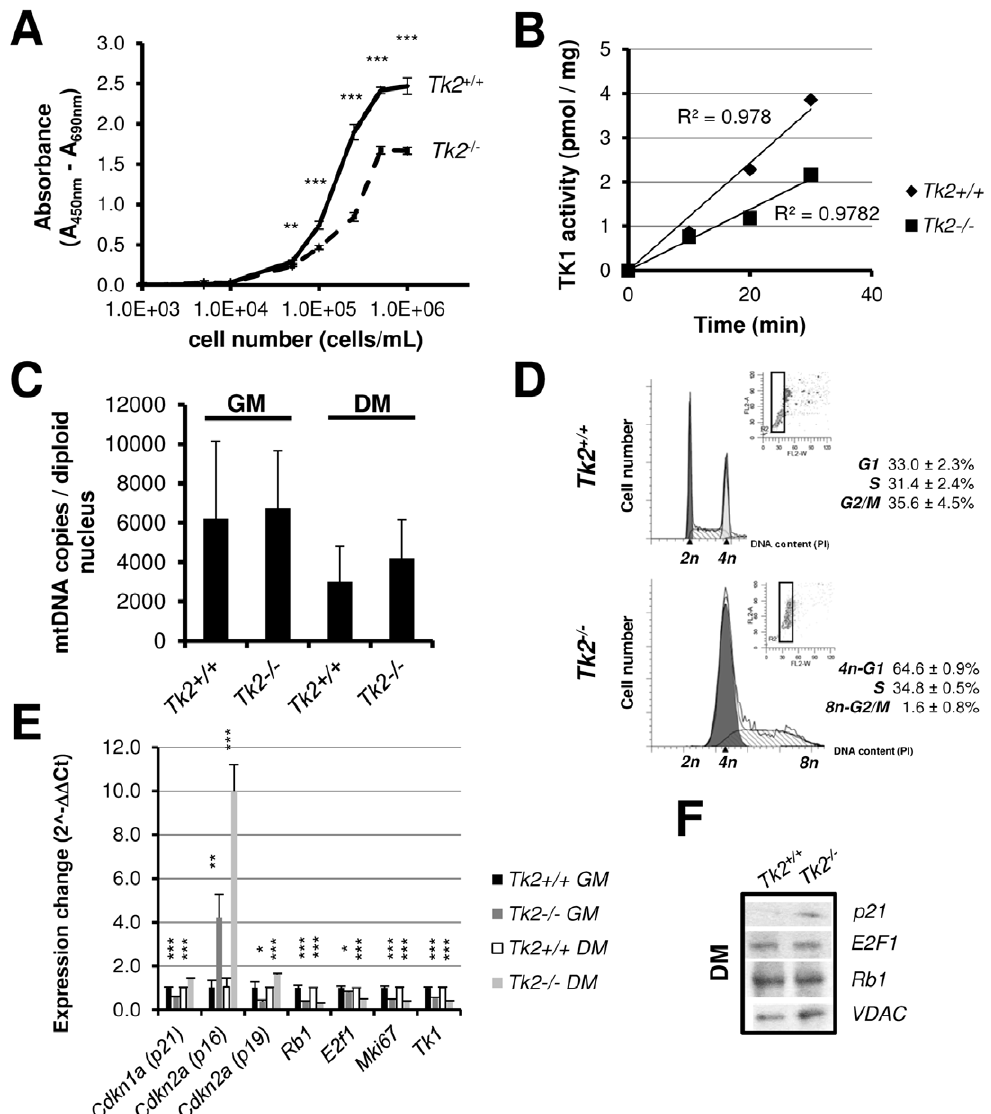
Figure 7. Tk2 + / + and Tk2 2 / 2 primary myoblasts characterization. A ) Growth of Tk2 + / + and Tk2 2 / 2 myoblasts in F-10/DMEM-based primary myoblast growth medium was determined by XTT proliferation assay (see methods). Data points represent mean 6 SD of measurements obtained from 4 independent myoblast cultures ( n =4). The P -values for statistical comparisons (two-tailed unpaired Student’s t-test) between Tk2 + / + and Tk2 2 / 2 data points are shown - ** P , 0.01; *** P , 0.001. B ) Thymidine kinase activity measured in both Tk2 + / + and Tk2 2 / 2 cultured myoblasts ( n =2). C ) mtDNA copy number of Tk2 + / + and Tk2 2 / 2 cultured myoblasts was measured by Real-time PCR in growth (GM) and differentiation conditions (DM, 8 days). D ) Flow cytometry analysis of Tk2 + / + and Tk2 2 / 2 myoblasts cell cycle, 24 hours after cells have been plated. Data were obtained from 3 independent experiments ( n =3) and were analysed using the ModFit LT software, in order to obtain the percentages of cells in G1, S and G2/M